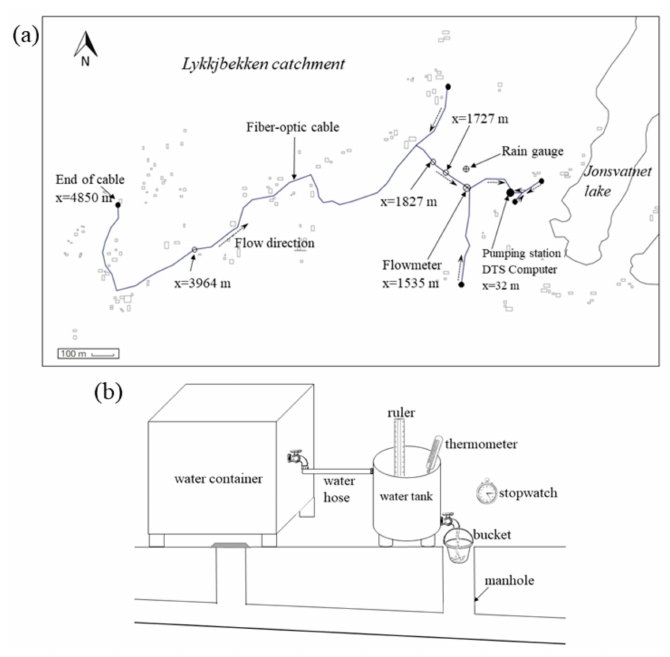
Figure 3. Schematic overview of the ( a ) DTS cable installation in the separate sewer network of Lykkjbekken catchment; and ( b ) experimental setup of the artificial inflow into the sewer network.